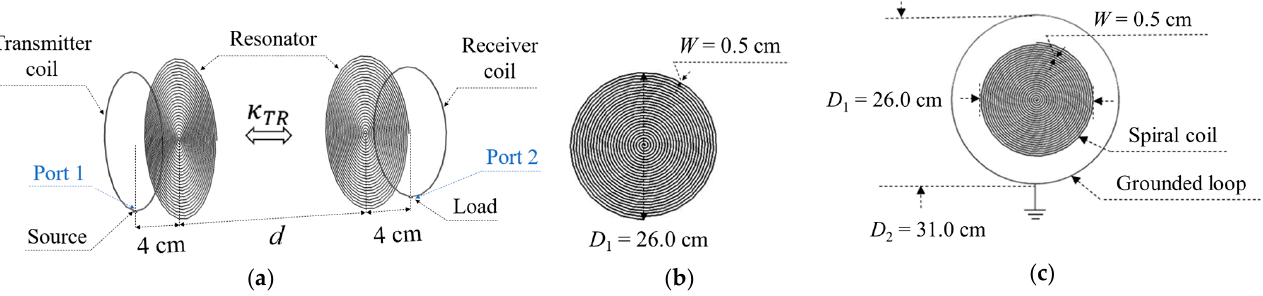
Figure 1. Geometrical structure of the proposed MRC-WPT system. ( a ) Four-coil MRC-WPT system. ( b ) Non-grounded resonator. ( c ) Proposed resonator with a grounded loop.